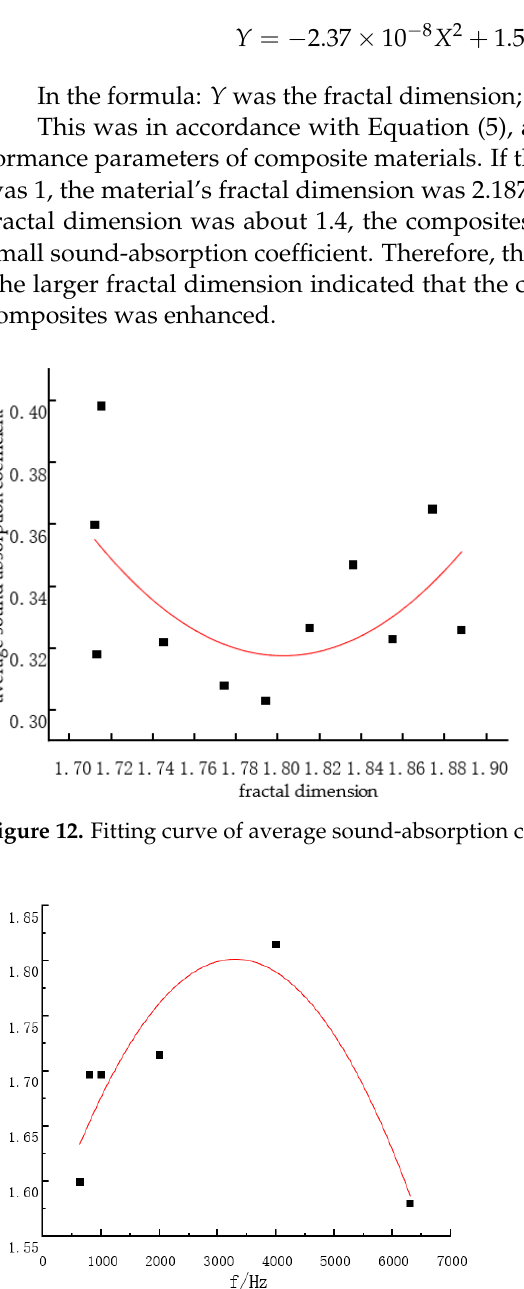
Figure 13. Fitting curve of fractal dimension and resonance sound-absorption frequency.